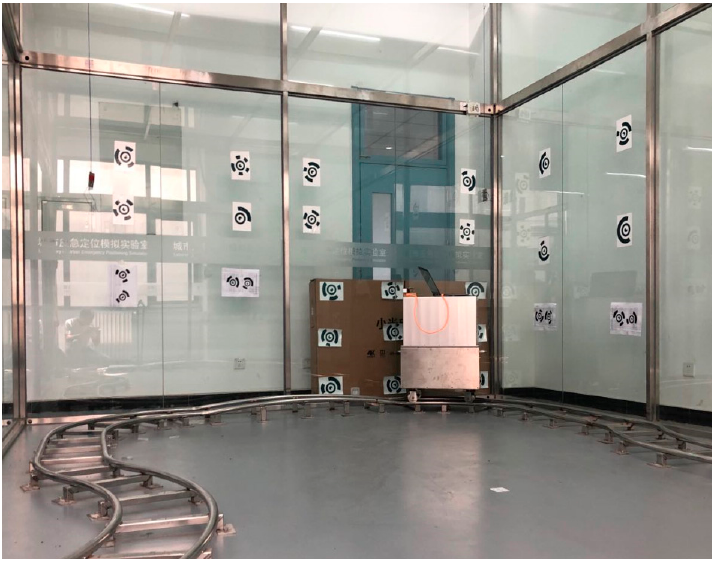
Figure 14. Experimental environment.